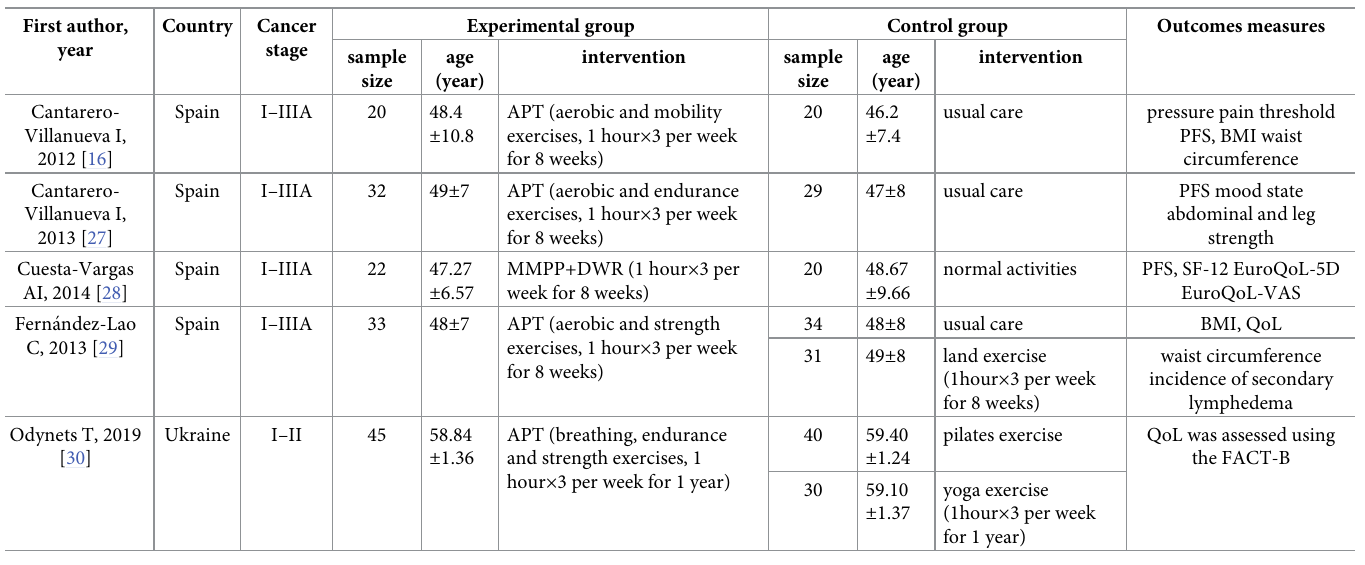
Table 1. Characteristics of studies included in the meta-analysis.